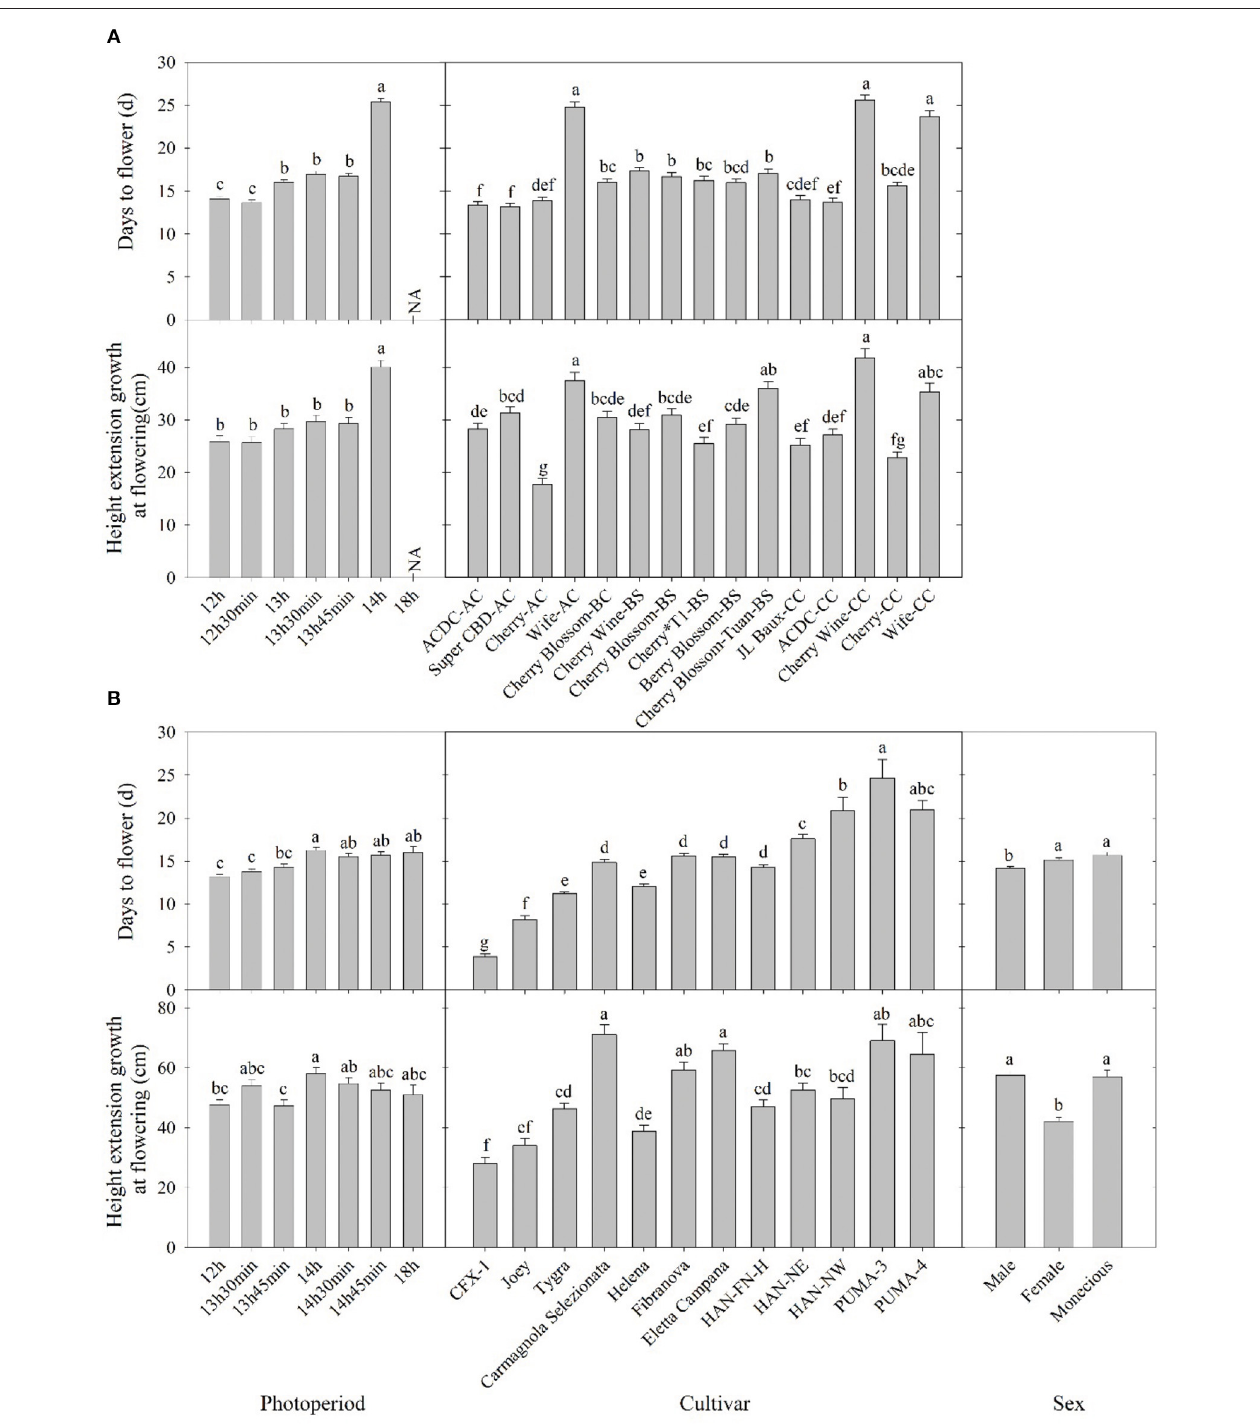
FIGURE 2 | Days to flower after lighting treatment initiated and height extension growth at the flowering of (A) essential oil and (B) fiber/grain cultivars under different photoperiods, cultivars, and/or sex from Expt. 1 and 2. Means sharing a letter are not statistically different by Tukey’s honest significance difference test at P ≤ 0.05. Error bars indicate standard